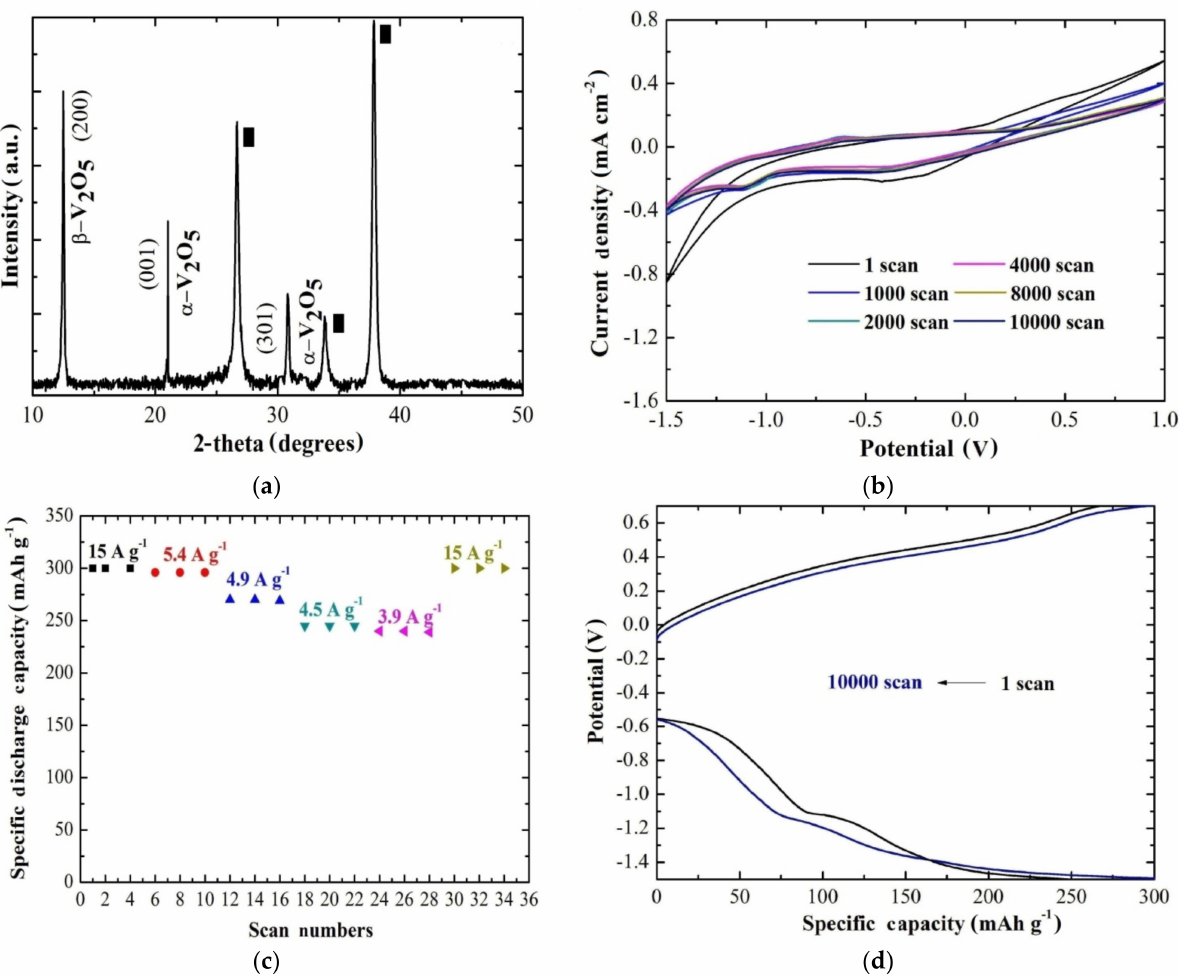
Figure 6. ( a ) XRD pattern of the AACVD V 2 O 5 coating at 600 ◦ C. ( b ) Cyclic voltammetry curves of AACVD V 2 O 5 (2 cm × 2 cm × 0.3 cm) at 600 ◦ C after 1, 1000, 2000, 4000, 8000, and 10,000 scans measured in 0.075 M and MgCl 2 for a scan rate of 10 mV s − 1 . ( c ) Rate capability of the same sample as in ( b ) at different specific current values ranging from 15 to 3.9 A g − 1 and then back to 15 A g − 1 . ( d ) Chronopotentiometric curves for the same sample as before at a specific current of 15 A g − 1 for the 1st and the 10000th scan